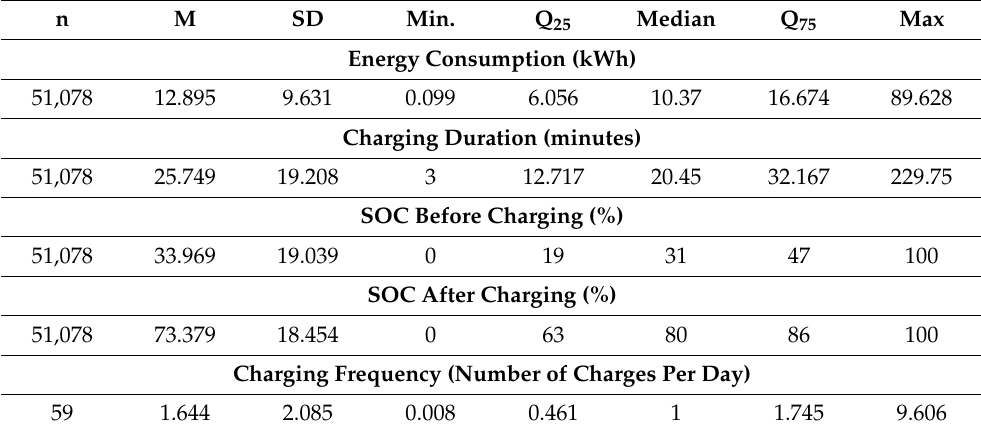
Table 3. Summary statistics of utilization variables for DCFC stations.